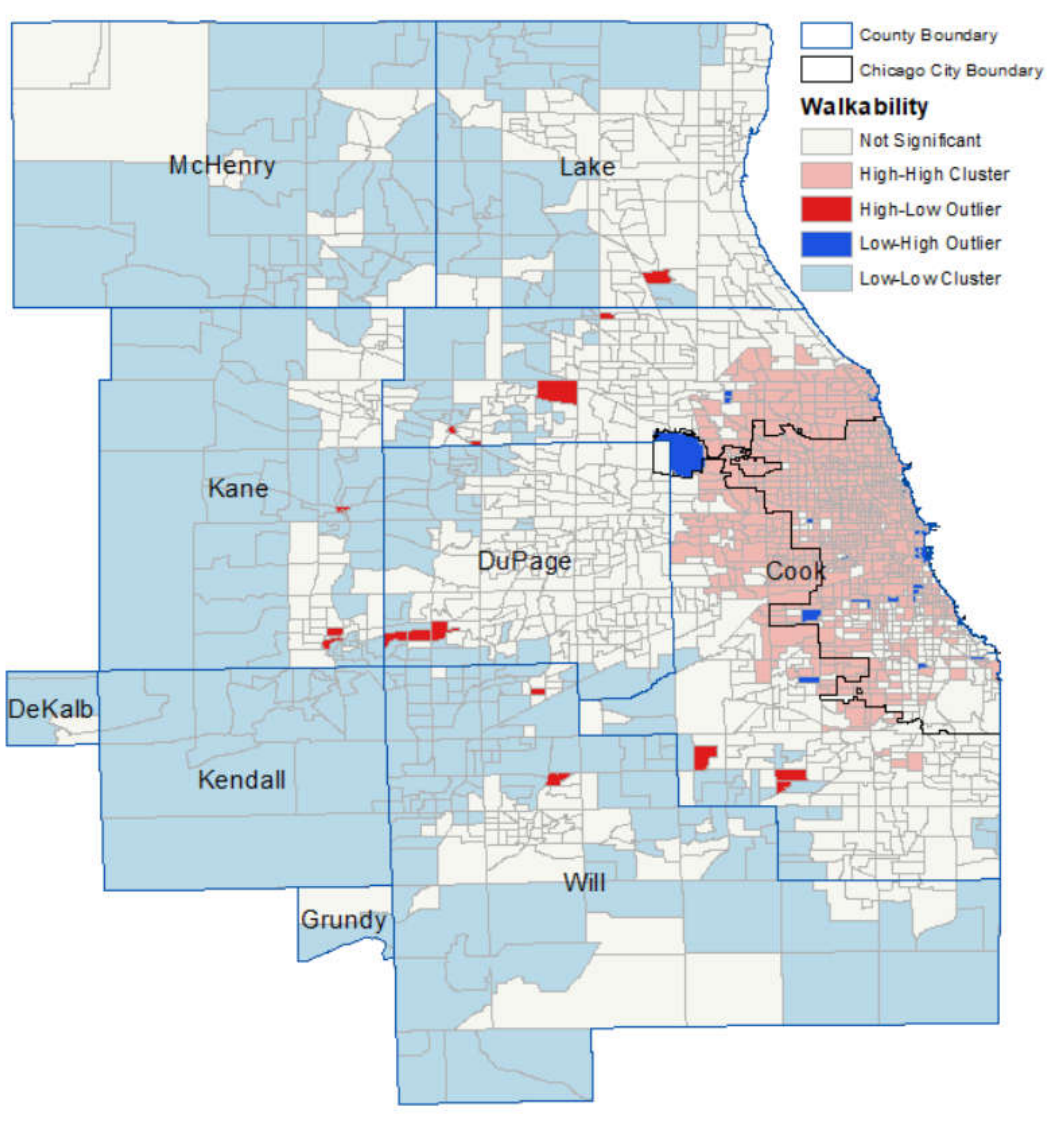
Figure 3. Clusters and outliers of the national walkability index. Table 1. Diagnostics for spatial dependence of health